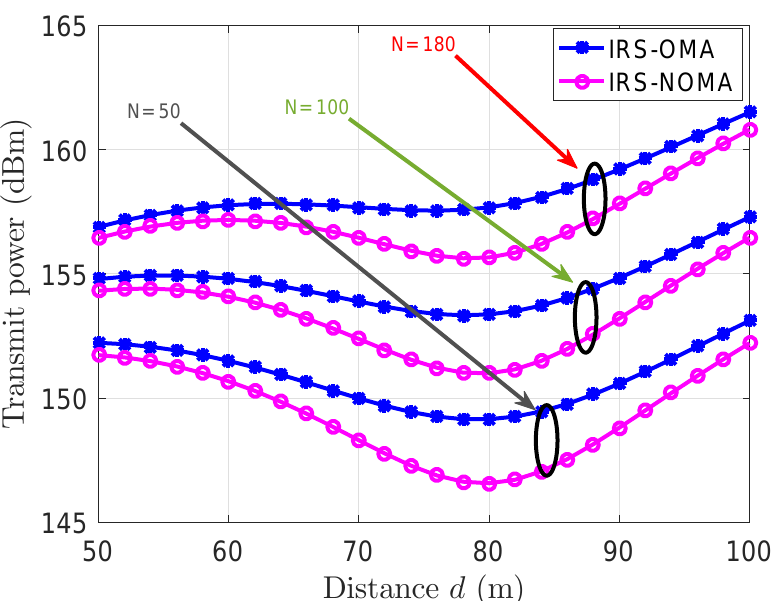
Figure 5. The required transmission power by IRS-NOMA and IRS-OMA for different destination locations to achieve a target rate of 100 Mbit/s.